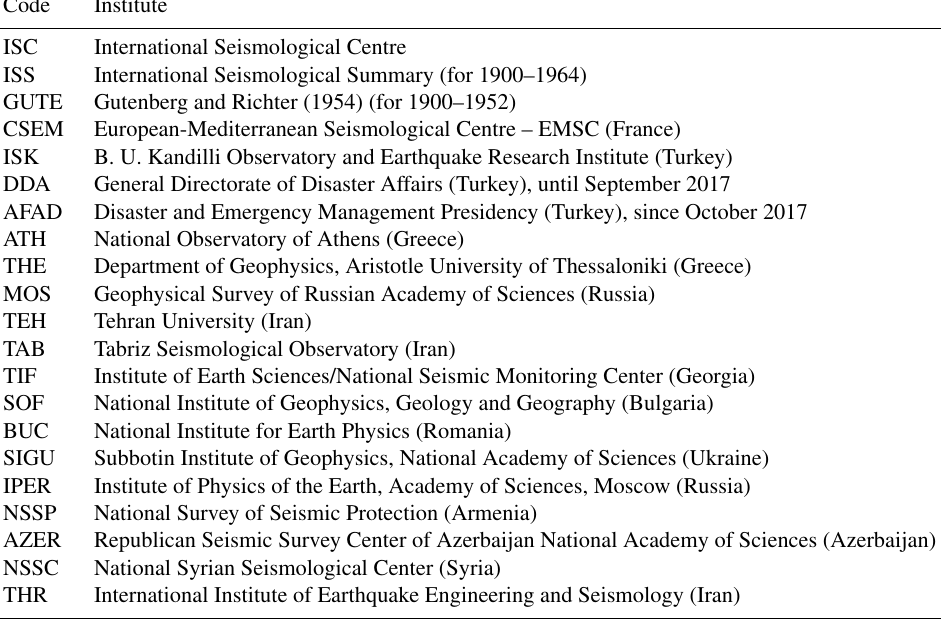
Table A1. The ISC contributor institutes.